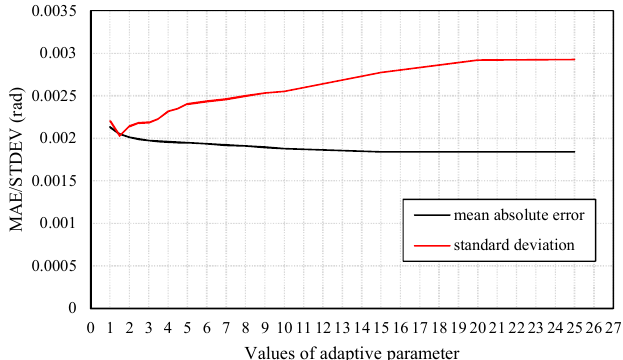
Figure 5. Standard deviations and mean values of absolute heading errors with respect to different values of the adaptive parameter c 0.